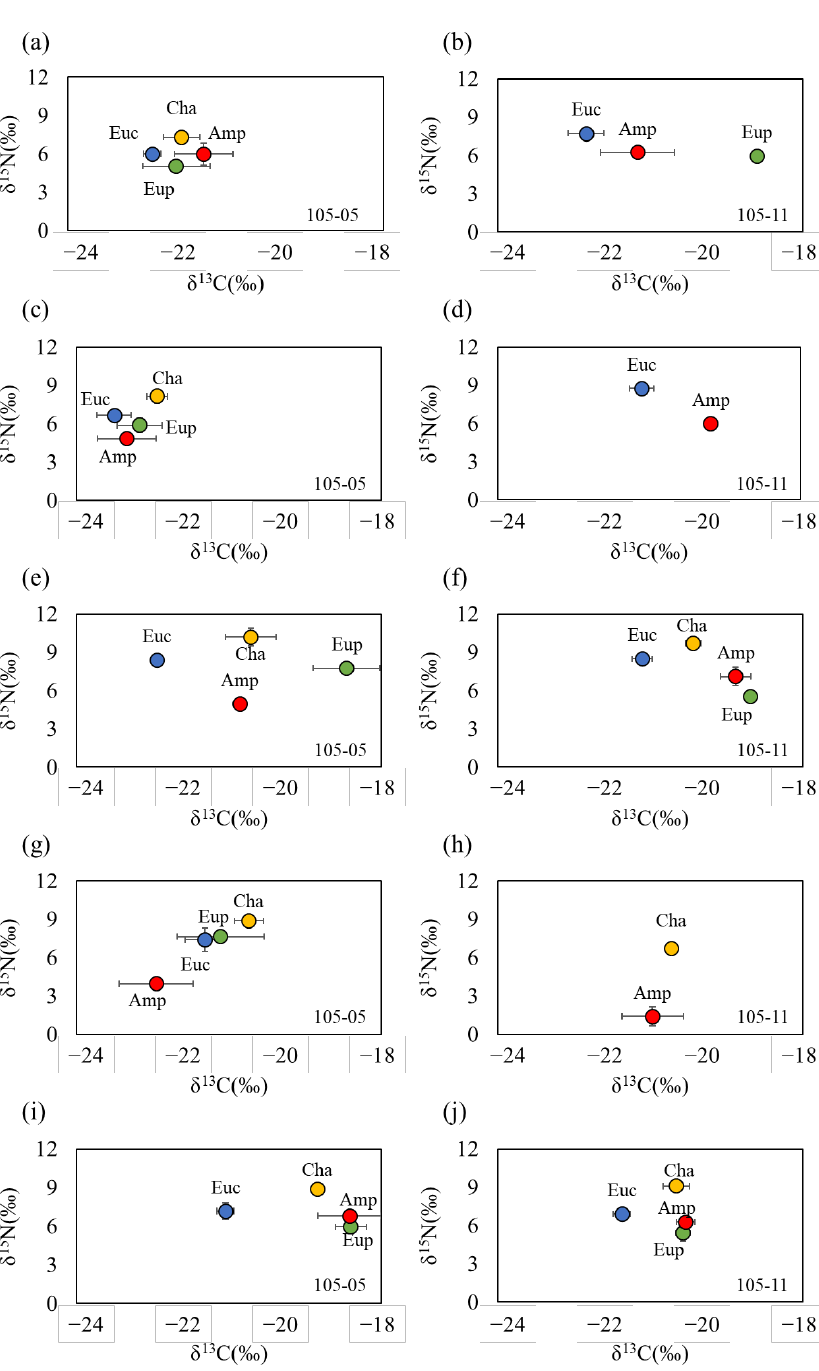
Figure 5. Spatiotemporal (August 2020: ( a , b ); October 2020: ( c , d ); February 2021: ( e , f ); April 2021: ( g , h ); August 2021: ( i , j ) δ 13 C and δ 15 N biplots of four zooplankton taxa collected at 105-05 ( a , c , e , g , i ) and at 105-11 ( b , d , f , h , j ) sites. Each taxon is depicted with different color (Euchaetidae: blue; Chaetognatha: yellow; Euphausiid: green; Amphipod: red).